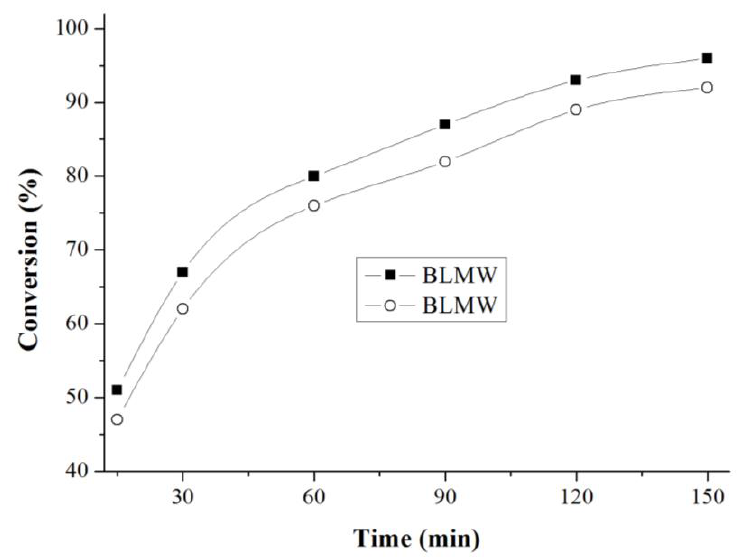
Figure 10. Effect of reaction duration (min) on the % conversion during DDPO esterification over catalyst. Reaction conditions: reaction temperature: 160 °C, molar ratio of DDPO:EtOH: 1:30, and catalyst amount: 5.0%.